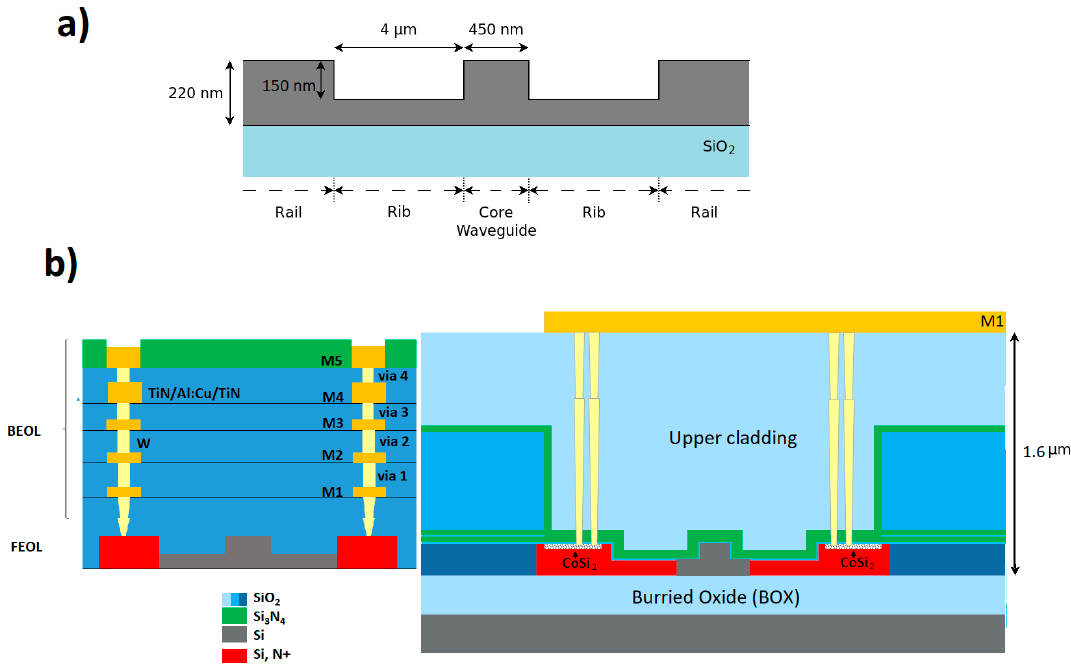
Figure 2. ( a ) Cross-section of the nano rib waveguide structure used in this work. ( b ) Schematic figure of the general IHP photonic BICMOS architecture. In this work, the wafers were only processed up to the first metallization